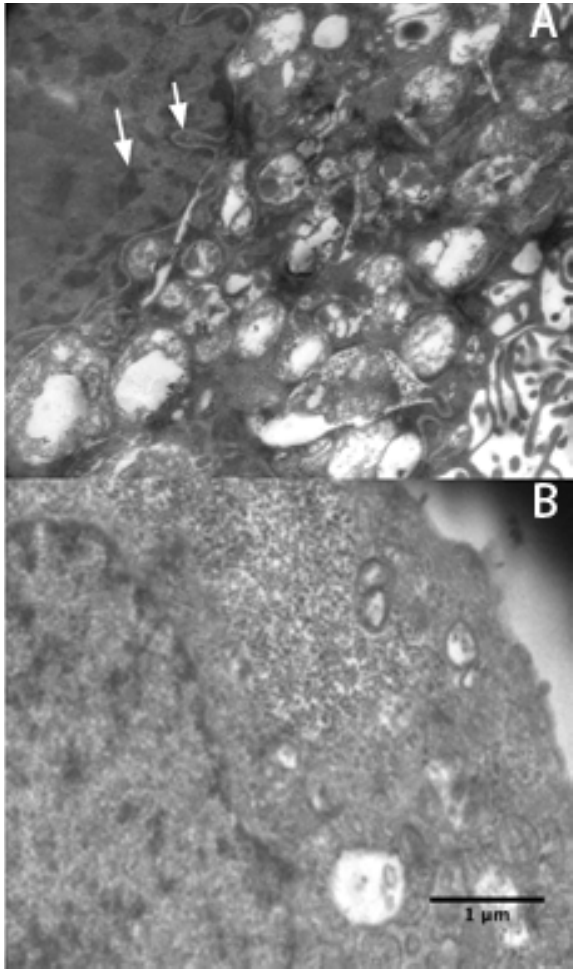
Figure 3. Electron micrographs were taken of SGC7901 cells treated ( A ) and untreated ( B ) with 16 ng/mL rVAA-I. Typical apoptotic morphological changes are denoted by an white arrow. Scale bar: 1 μ